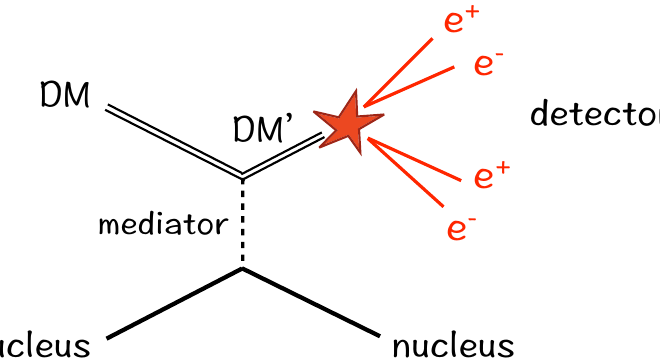
Figure 1 . A schematic picture of self-destructing DM, where DM denotes the cosmologically long-lived state and DM’ denotes the very short-lived